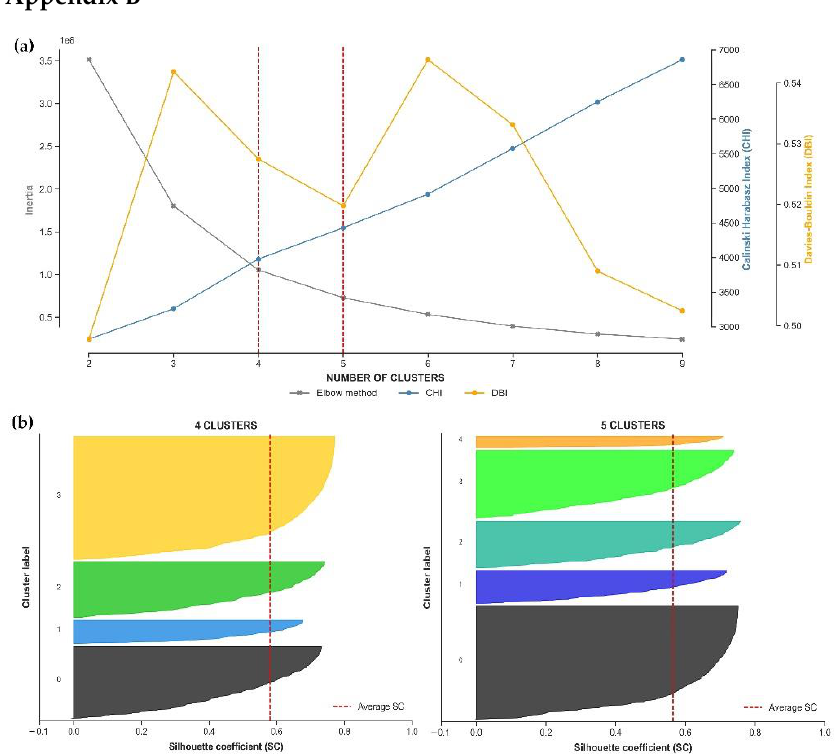
Figure A2. Cluster metrics for R-factor calculated by the RUSLE methodology including ( a ) CHI, DBI, the elbow method and ( b ) the silhouette score coefficient.